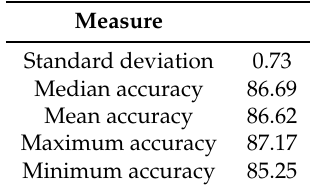
Table 12. SVM3 (reduced feature set using GA).